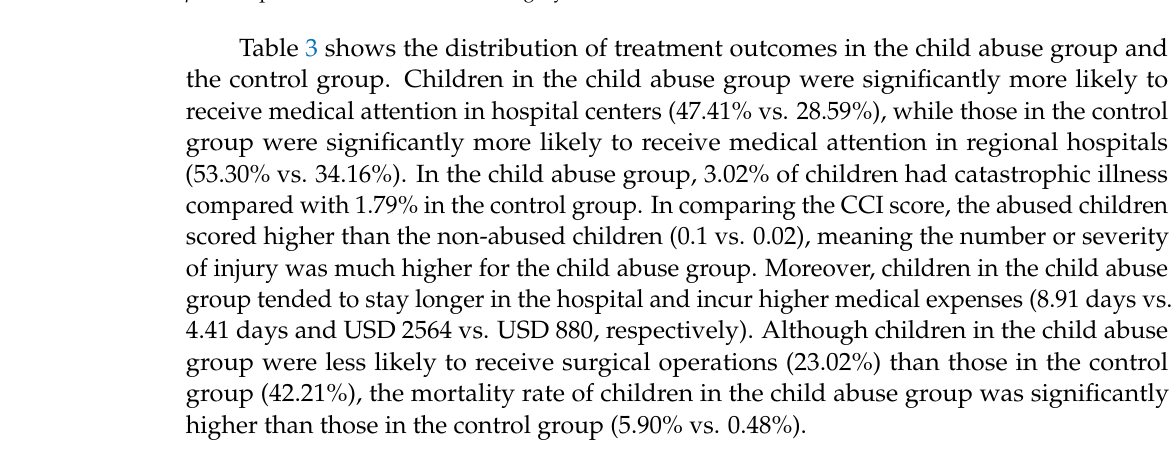
Table 3. Outcomes of children with child abuse and